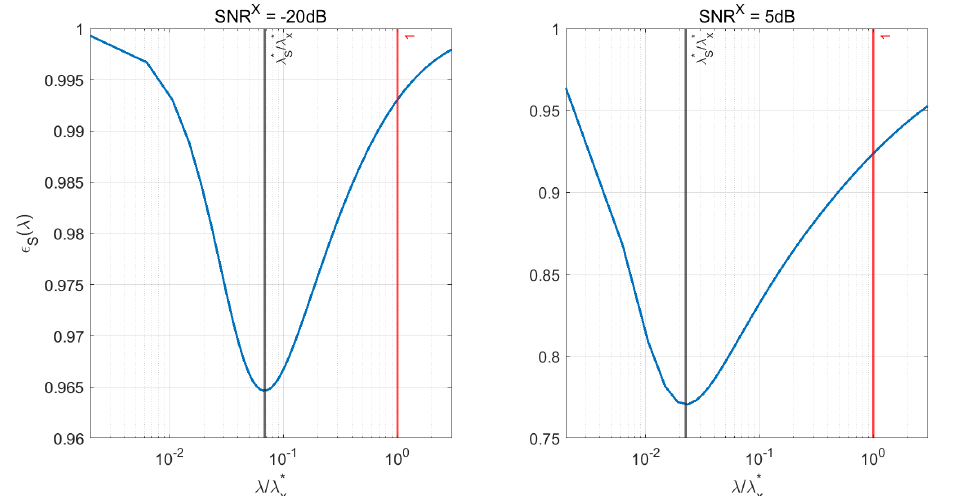
Figure 6. Reconstruction error ε S ( λ ) for two simulated data mimicking MEG signals with SNR X = − 20 dB (lowest considered signal–to–noise ratio (SNR), left panel) and SNR X = 5 dB (highest considered SNR, right panel). In each panel, black and red vertical lines highlight the values of ε S ( λ ) in correspondence of λ ∗ and λ ∗ x , S